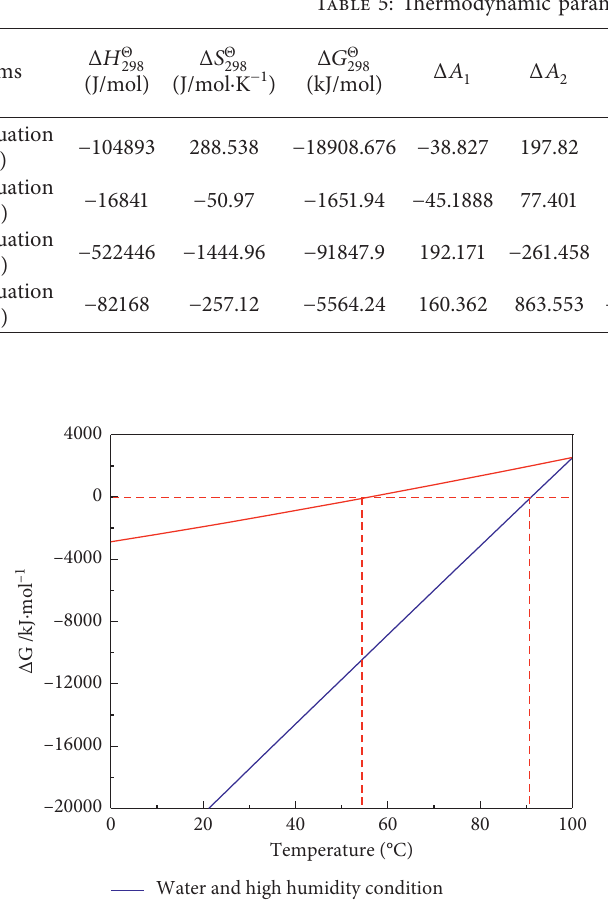
Table 5: Thermodynamic parameters of different reactions.